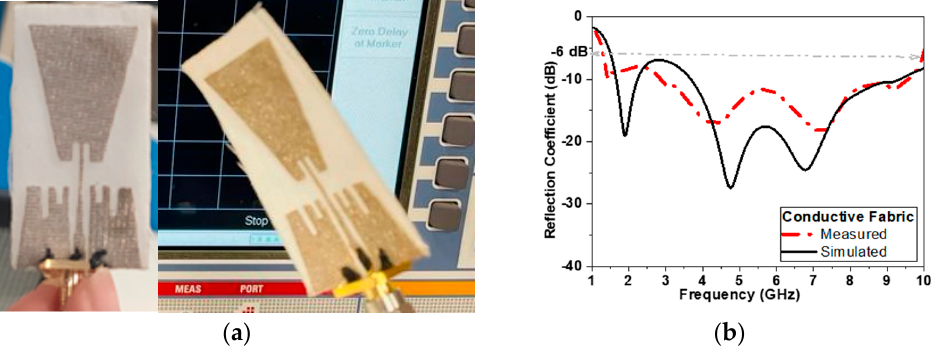
Figure 12. ( a ) Photo of fabricated antenna-based sensor using copper conductor tape and ( b ) meas- ured and simulated reflection coefficient in dB versus frequency.